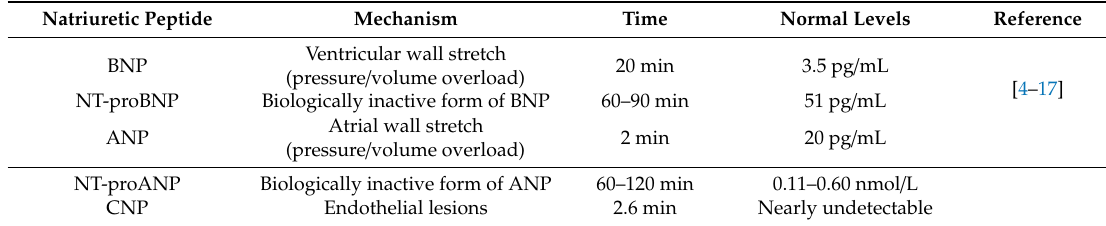
Table 2. The biological characteristics of natriuretic peptides. ANP- atria natriuretic peptide; BNP- B type natriuretic peptide; CNP- C-type natriuretic peptide; * values may vary slightly across studies. Natriuretic